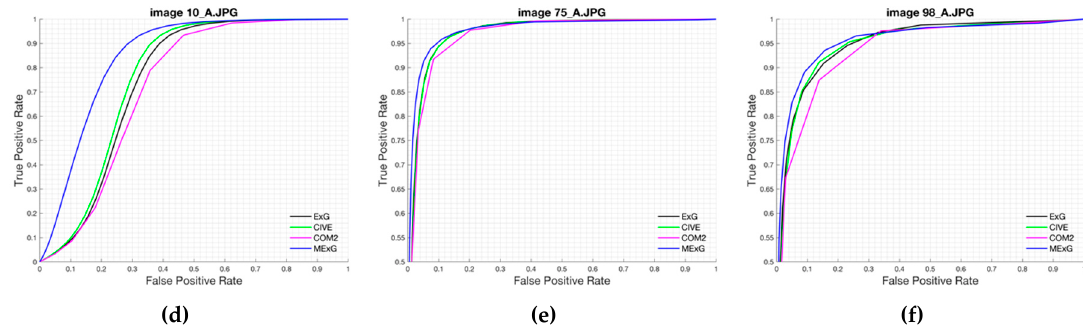
Figure 5. PR plots (first row) and ROC curves (second row) for three images of the proposed data. Performance evaluated on the images: ( a ) and ( d ) 10_A; ( b ) and ( e ) 75_A; and ( c ) and ( f ) 98_A.